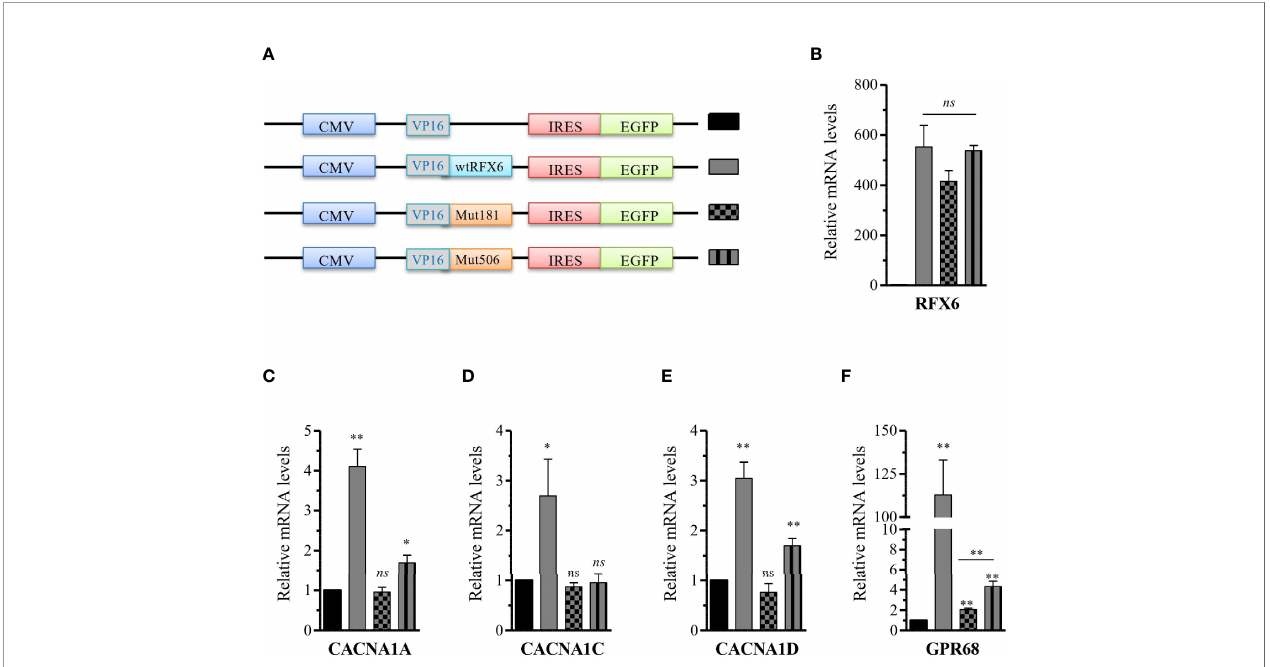
FIGURE 6 | Differential activation of R FX6 targets gene expression by wtRFX6 or Mu tR181W-R FX 6 or MutV506G-RFX6 in EndoC- b H2 cells. (A) Schematic presentation of the constructs with trans-activation domain VP16 and I ERS-EGFP used to overexpress wt or Mut R FX6 proteins (B) Fort y-eight hours posttransfection, GFP+ cells were FACS sorted and analyzed for the expression of R FX6 by RTq PCR in EndoC- b H2. (C – F) RT qPCR analysis of CACNAlA, CACNA1C, CACNA1D and G PR 68 in EndoC- b H2 post 48h transfected with wt or Mut RFX6. Da ta are mean of ± SEM of three to four experiments. *p < 0.05; **p <0.01; ns, non signi fi